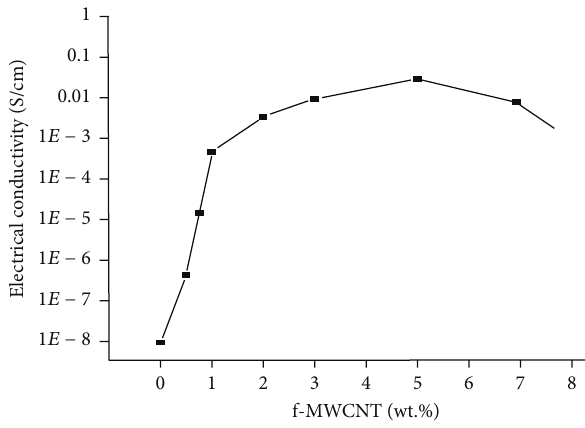
Figure 14: Electrical conductivity of nanocomposites.